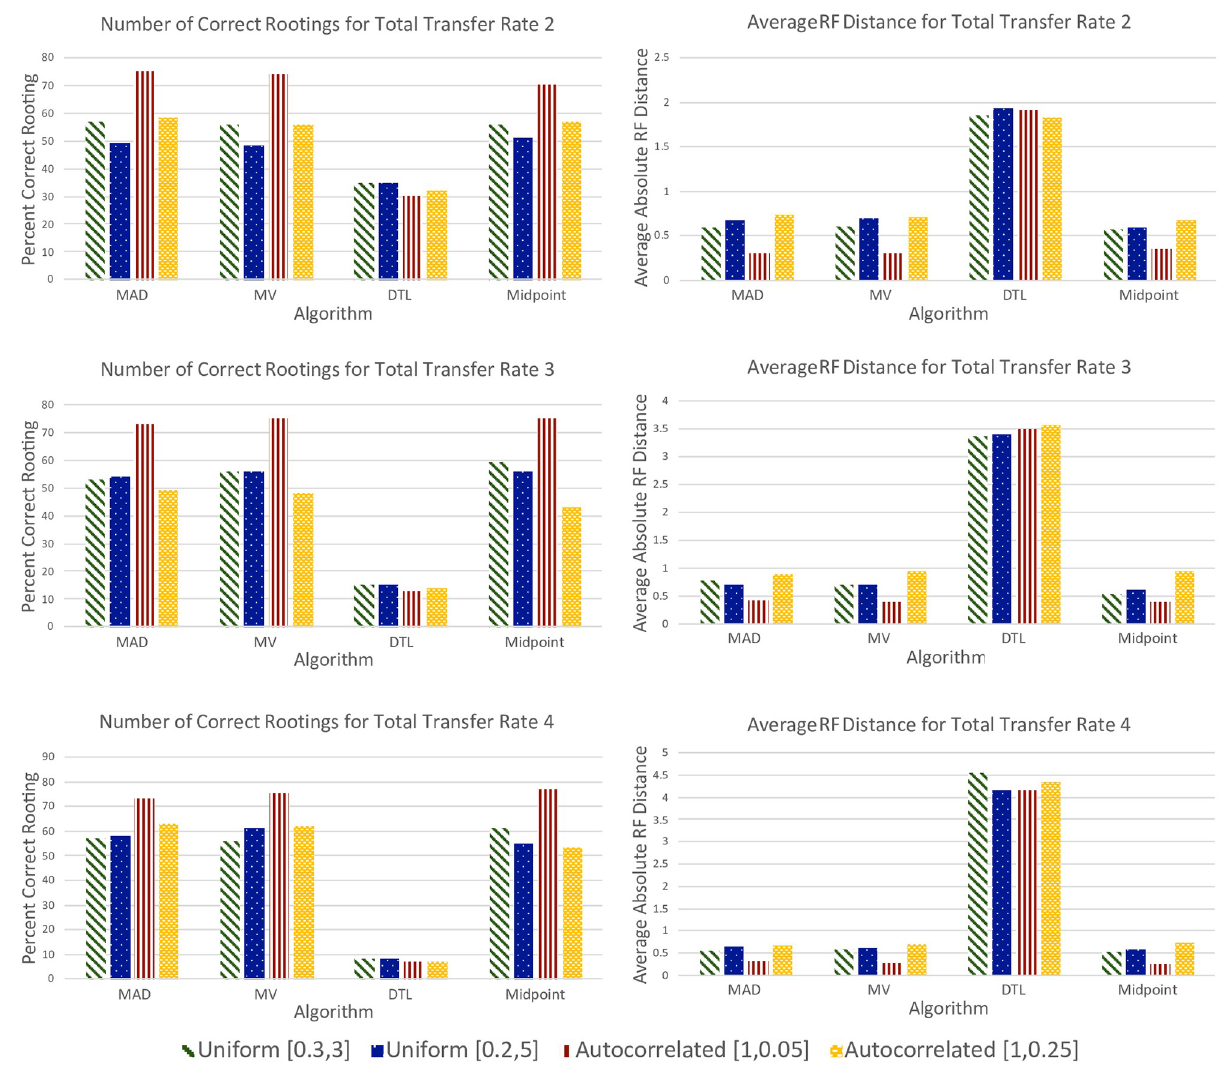
Fig 4. Results on very high transfer rate data sets. As the plots show, MAD, MV, and midpoint rooting are robust to increasing transfer rates and show comparable accuracy on the 12 very high transfer rate data sets. On the other hand, DTL rooting, while unaffected by substitution rate variation along edges, becomes progressively worse as the transfer rate increases and infers far worse root positions than the other three rooting